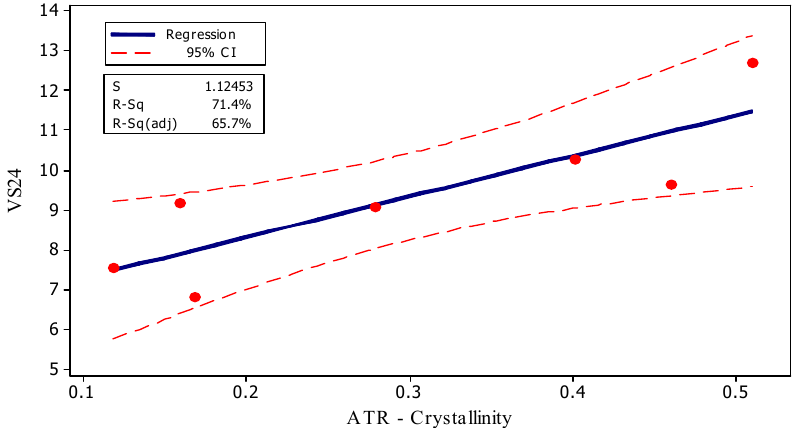
Figure 8. Fitted ‐ line plot between Attenuated Total Reflectance ‐ crystallinity versus physical properties of VS in the seven treatments of Scots pine studied (VS = volumetric swelling after 24 h ‐ immersion in water).